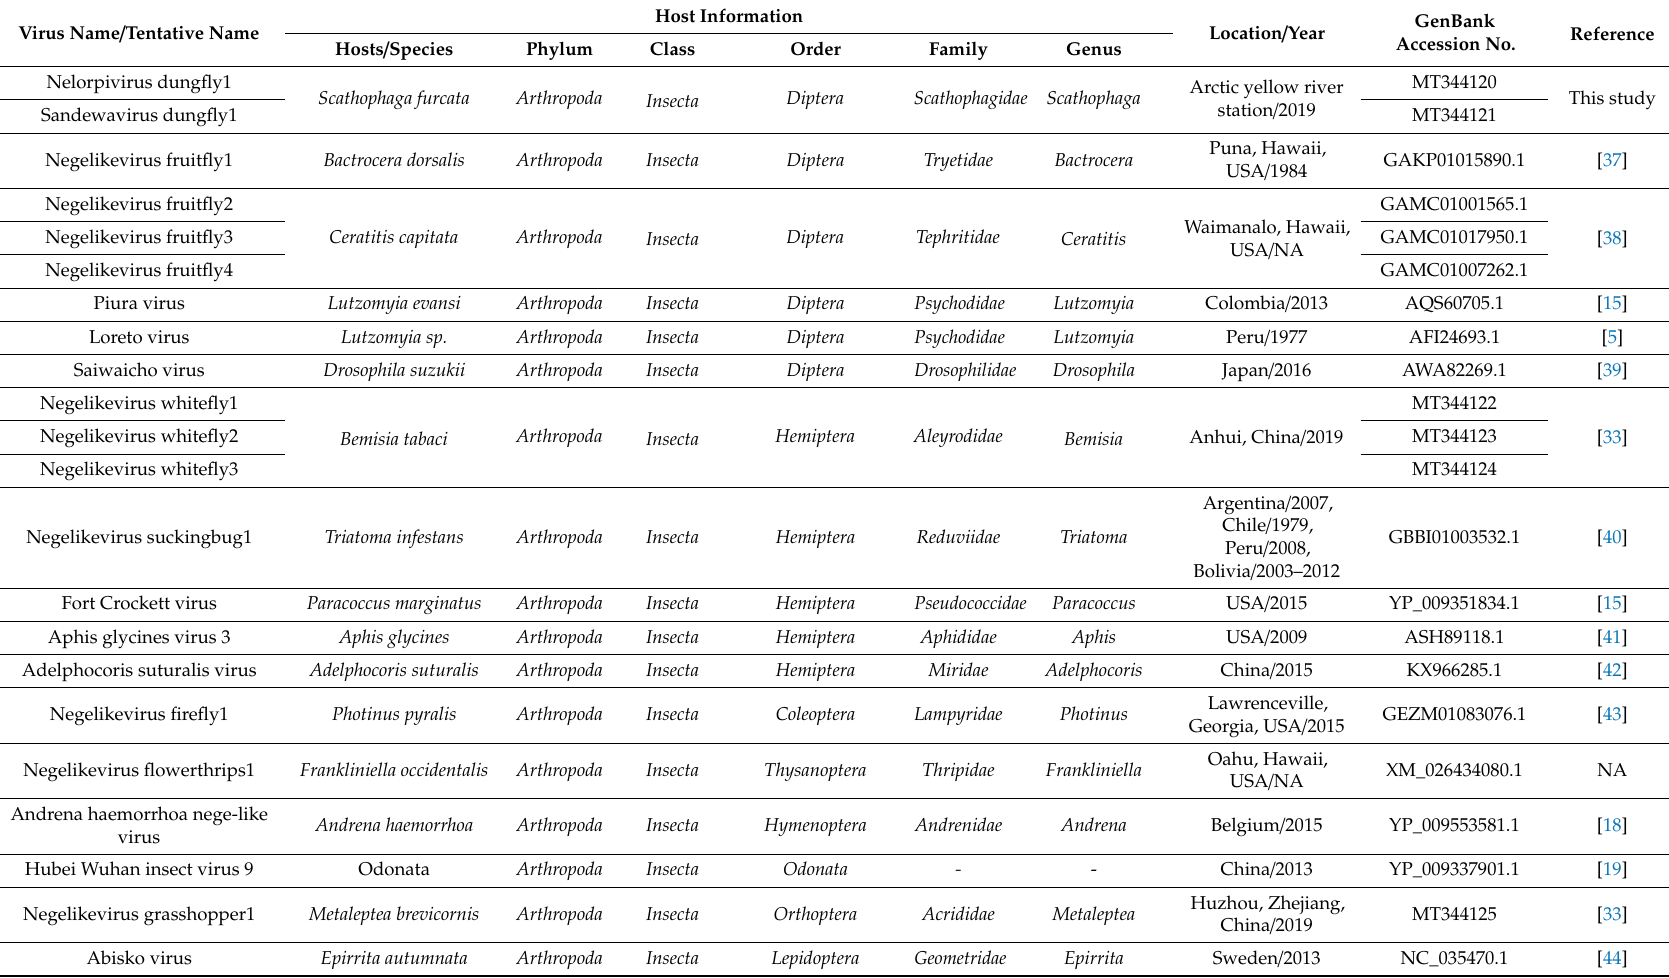
Table 2. Broad host range and wild distribution of nege-like viruses in